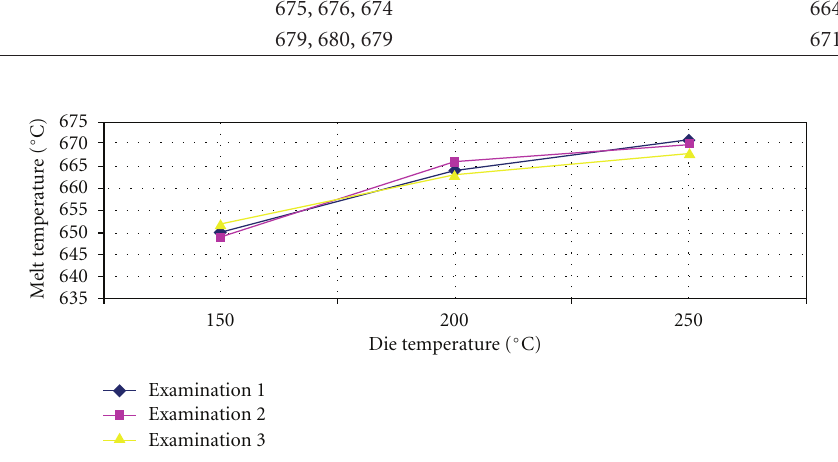
Figure 3: Melt temperatures at the end of the die and end injection versus die